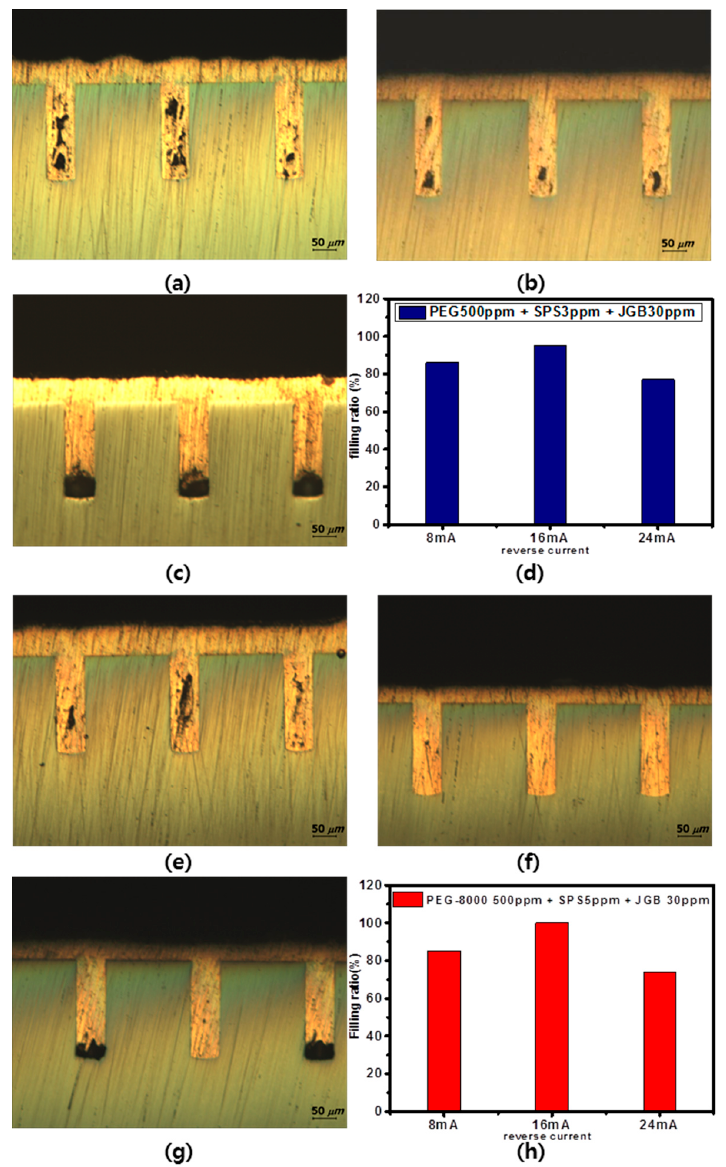
Figure 10. Cross-sectional OM images and filling ratio graphs with changes in SPS concentration and reverse current conditions. ( a – d ) 8 mA, 16 mA, and 24 mA in SPS 3 ppm, respectively. ( e – h ) 8 mA/cm 2 , 16 mA/cm 2 , 24 mA/cm 2 in SPS 5 ppm, respectively.